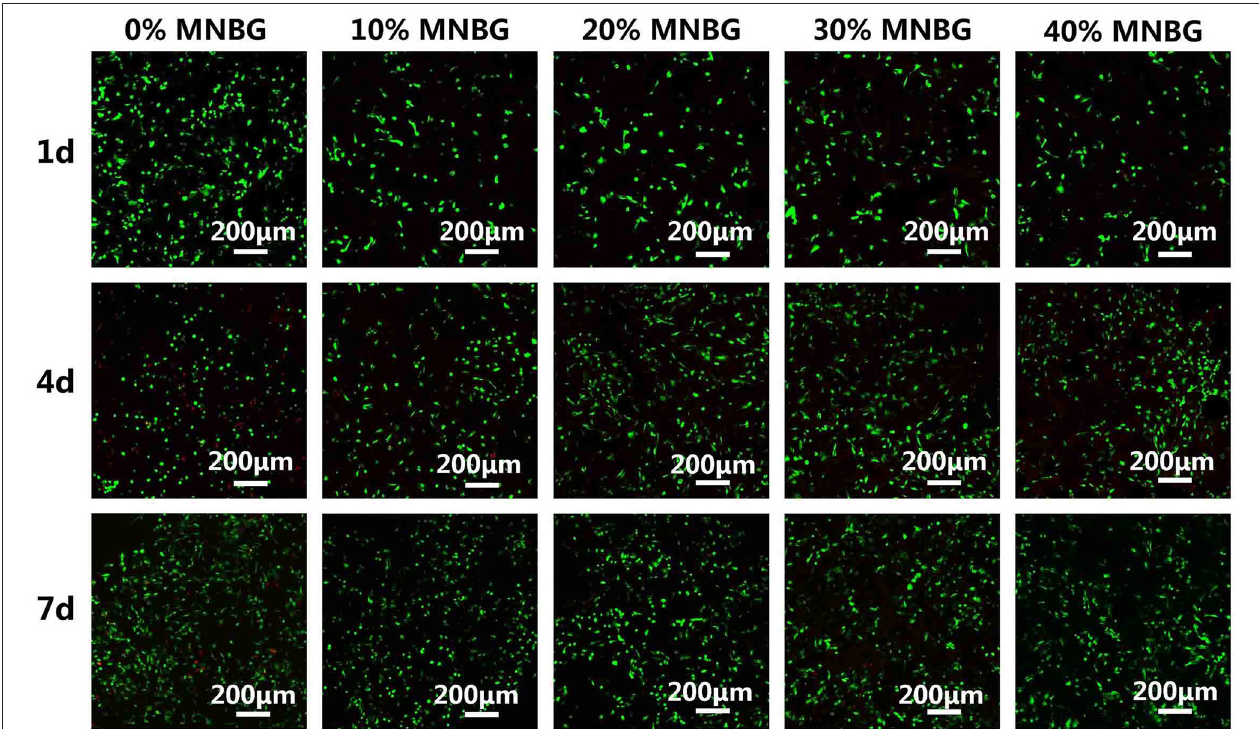
FIGURE 7 | HUVECs viability evaluation cultured on PLGA-MNBG scaffolds with various MNBG concentrations detected by Live-Dead assay at day 1, 4, and 7. Green represents living cells and red represents dead cells.